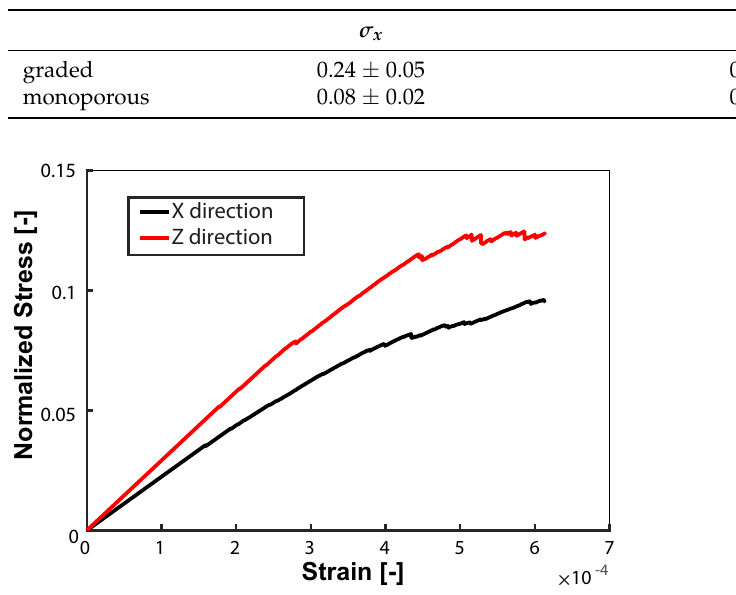
Figure 3. Stress–strain curves under uniaxial load along two different